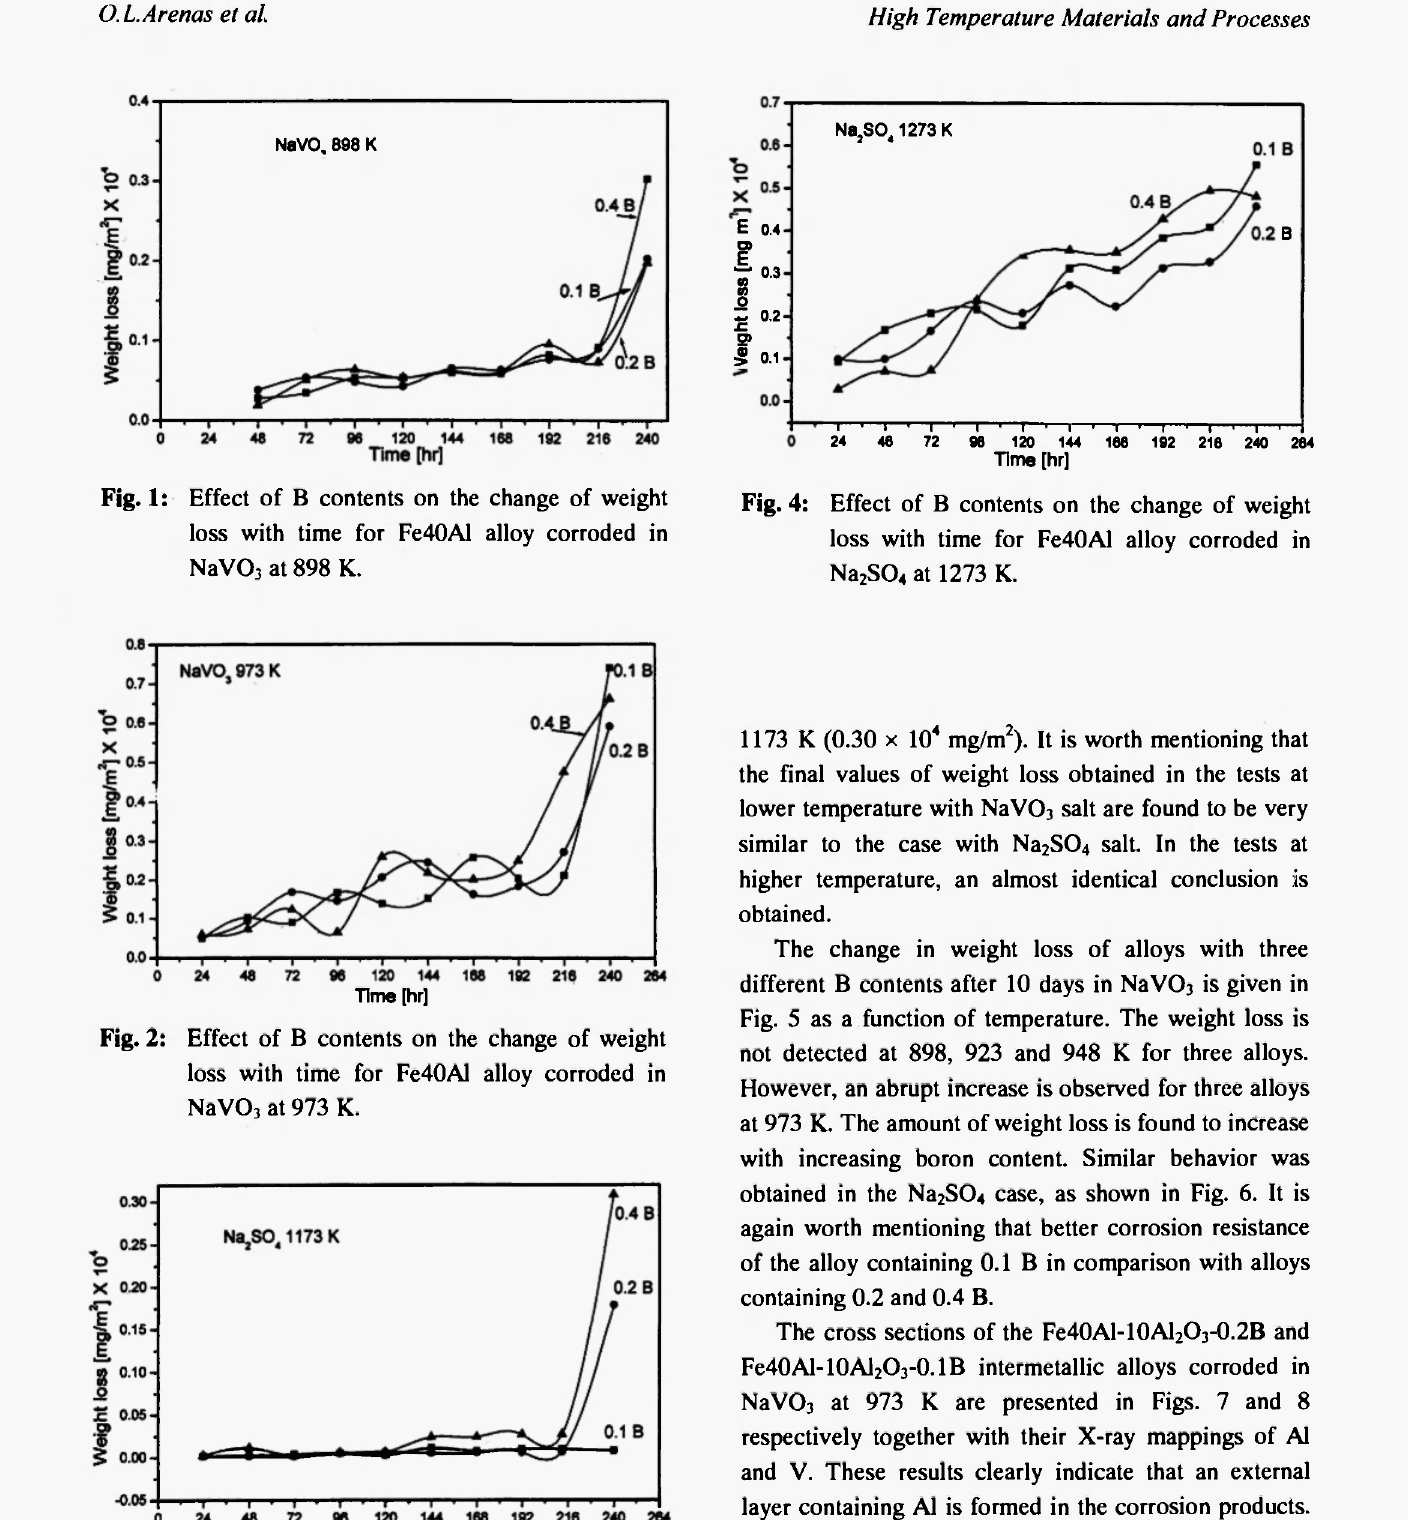
Fig. 3: Effect of Β contents on the change of weight loss with time for Fe40Al alloy corroded in Na 2 S0 4 at 1173